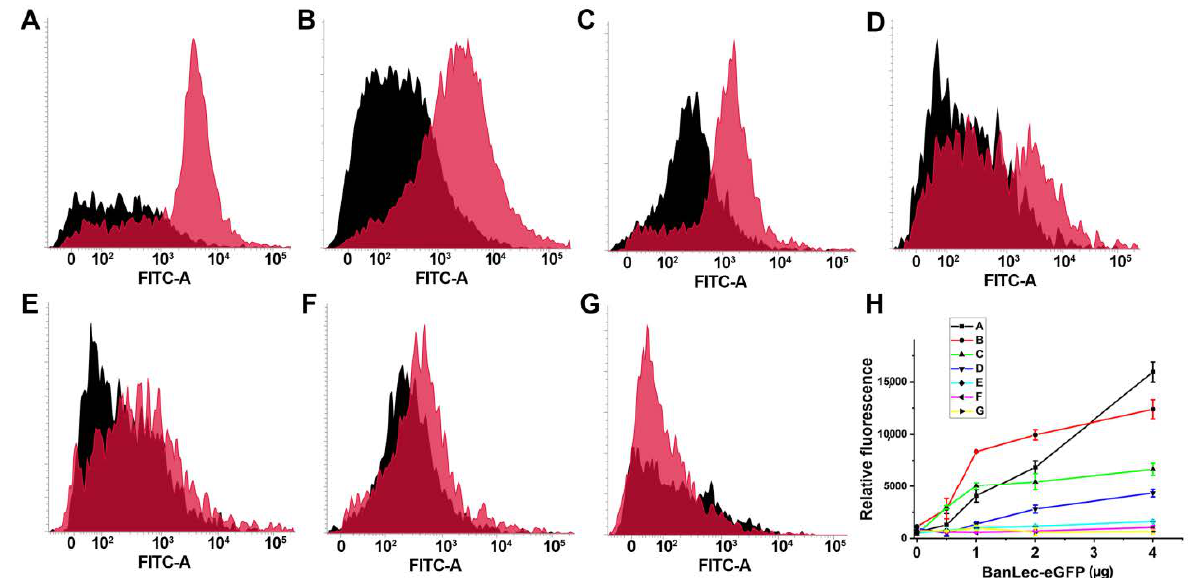
Figure 3. Flow cytometric analysis of the binding of BanLec-eGFP chimera to different strains of Salmonella enterica , subspecies enterica. ( A ) serovar Typhi clinical isolate 12; ( B ) serovar Typhimurium isolate 2865; ( C ) serovar Typhimurium ATCC 14,028; ( D ) serovar Typhi clinical isolate 1243; ( E ) serovar Typhimurium isolate B; ( F ) serovar Enteritidis clinical isolate E; ( G ) serovar Enteritidis ATCC 13,076; Black histogram—unstained bacteria; pink histogram—bacteria stained with 14 µg of BanLec-eGFP chimera; ( H ) dependence of FITC-A Median, labeled relative fluorescence on the concentration of BanLec-eGFP chimera. The strains are labeled as described above.